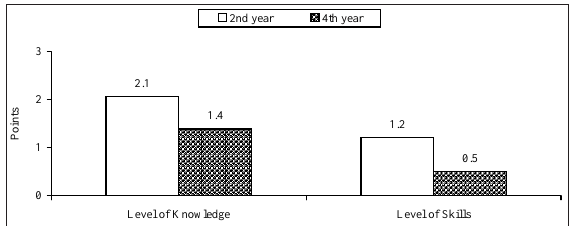
Fig. 4. General evaluation of the level of knowledge and skills acquired at LAPE (–5 — very low; +5 — very high)